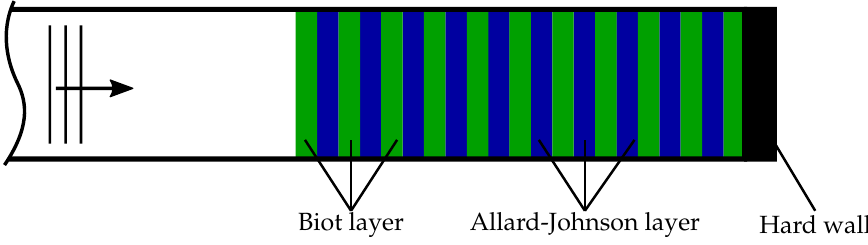
Figure 7. Modeling approach for the acoustic response of stapled